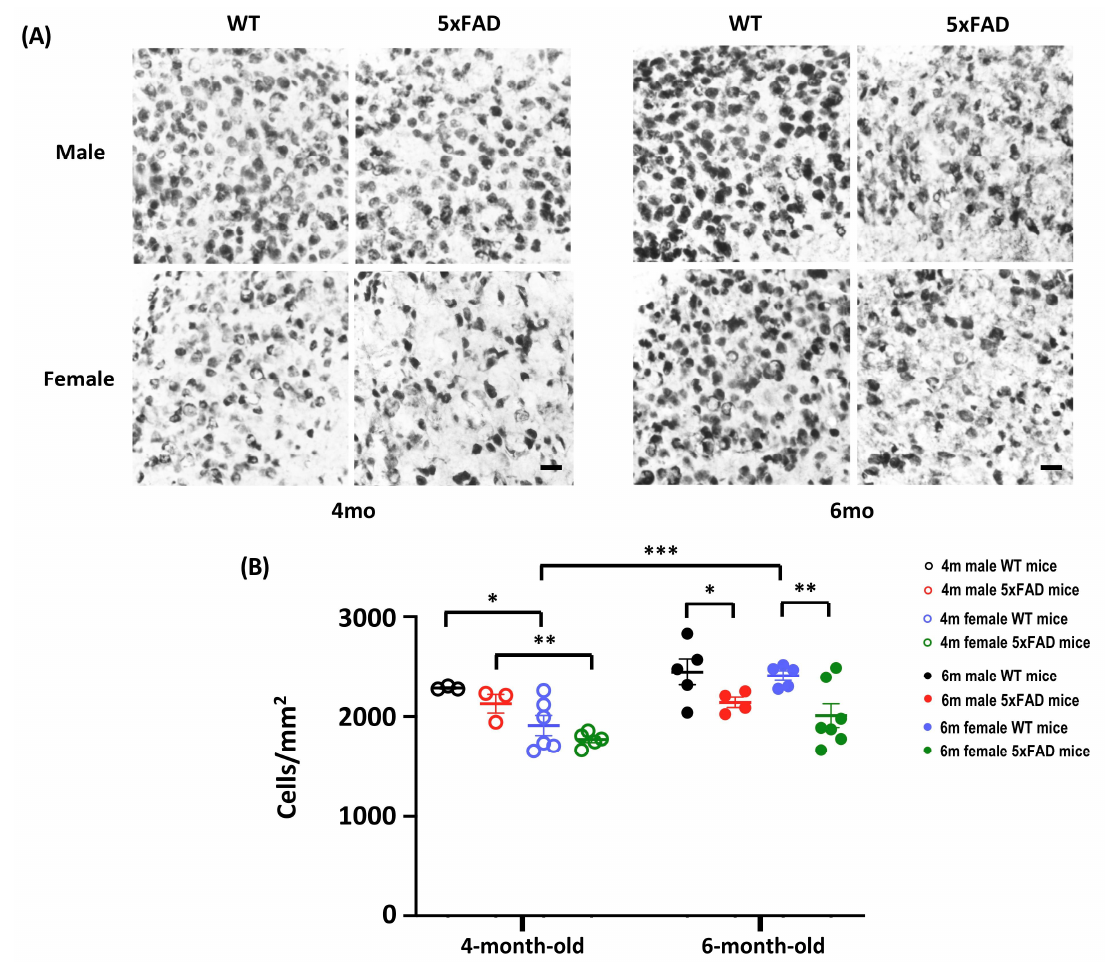
Figure 3. Neuronal count in the subiculum of 4- and 6-month-old WT and 5xFAD mice. ( A ) Repre- sentative images of subiculum sections stained with anti-NeuN from 4- and 6-month-old mice. A sparser neurone density was observed in 6-month-old 5xFAD mice. Scale bar: 20 μm. ( B ) The NeuN + mature neurones showed main effects of Age (F (1, 32) = 9.495, p = 0.004), Sex (F (1, 32) = 12.467, p = 0.001), Genotype (F (1, 32) = 10.713, p = 0.003), and Age × Sex (F (1, 32) = 4.87, p = 0.035). A Priori analysis showed significant differences in the number of mature neurones in WT and 5xFAD mice at 6 months (Male: p = 0.039; Female: p = 0.003), but not at 4 months, indicating the onset of neuronal loss at 6 months. A Priori analysis also revealed sex-dependent differences in the number of neurones at 4 months (Male WT vs. Female WT: p = 0.02; Male 5xFAD vs. Female 5xFAD: p = 0.005), and a higher number of neurones in 6-month-old female WT mice compared to 4-month-old counterparts ( p = 0.001). Data presented as mean ± S.E.M. for comparisons. Scatterplot shows individual values. ( n = 3–7; * p < 0.05, ** p < 0.01, *** p < 0.001). 3.4. Increased Neuroinflammation in 5xFAD Mice at 6 Months Astrocytic activation is a prominent hallmark of AD rodent models and patients. To characterize astrocytic activity in 5xFAD mice, brain sections were stained with a glial fibrillary acid protein (GFAP) antibody to visualize astrogliosis (Figure 4A). Given that severe amyloid pathology was observed in the hippocampus by 4G8 staining, we focused on GFAP expression changes in the hippocampus. We found no significant differences in hippocampal GFAP expression between WT and 5xFAD male mice regardless of age. However, the region-specific analysis revealed enhanced GFAP expression in the CA1 and DG of 6-month-old 5xFAD mice compared to their WT counterparts (Figure 4B), in- dicating increased neuroinflammation in male 5xFAD mice at 6 months. On the other